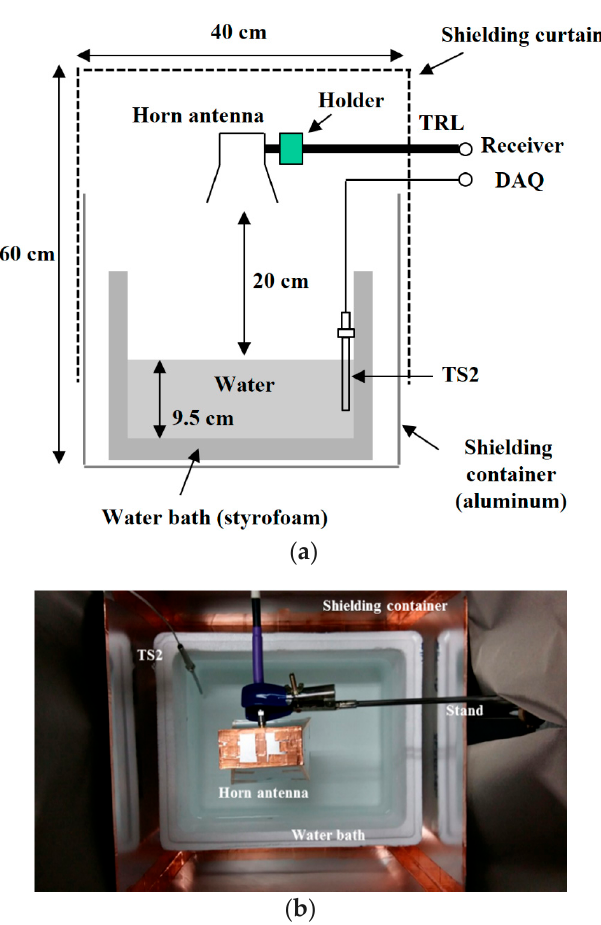
Figure 7. Experimental setup for water temperature measurement. ( a ) Diagram. ( b ) Photograph.